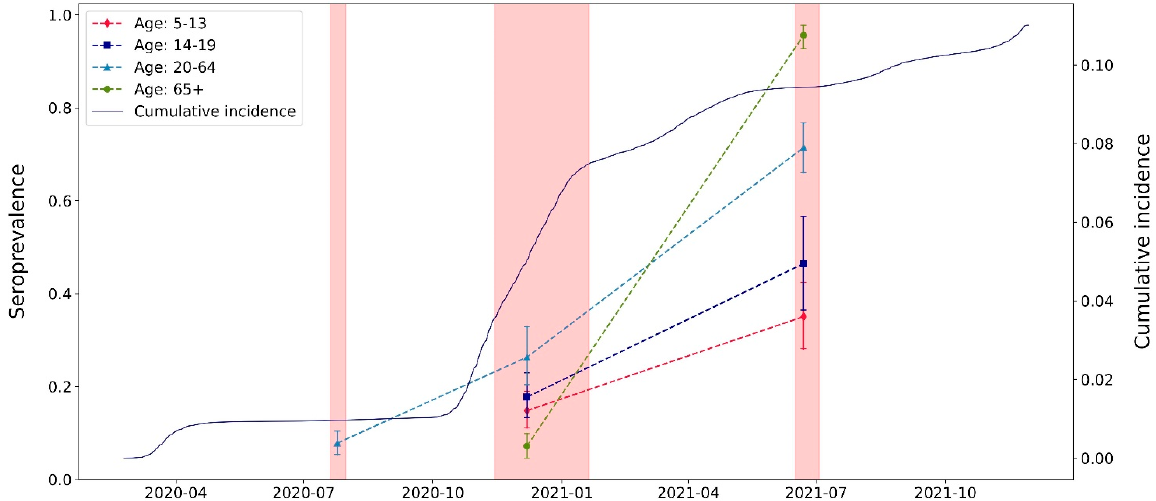
Figure 2. Seroprevalence estimates with 95% CI at each serosurvey (vertical red banners), and cumulative incidence rate of laboratory-confirmed COVID-19 cases in the region (solid line). The proportion of still immunonaive older adults (i.e., those who had not developed antibodies) was the highest in December 2020 and the lowest in July 2021, and it was in- versely associated with age for the remaining age groups at the last follow-up, when the vaccines were not yet approved for children. All the observed increases over time in sero- prevalence were statistically significant within age groups (Chi 2 > 100.1 with 4 df, and all p values < 0.001). Estimates varied by up to 10% within the regional districts of southern Switzerland, but seroprevalence was not significantly higher in the southern districts bor- dering the Italian region Lombardy ( p > 0.05 for all comparisons), which was heavily hit during the first pandemic waves (Figure 3) [33]. Figure 3. Temporal evolution of proportion of seropositive participants in different geographic re- gions of southern Switzerland (Ticino). The Italian Lombardy region borders the southern part of Ticino.